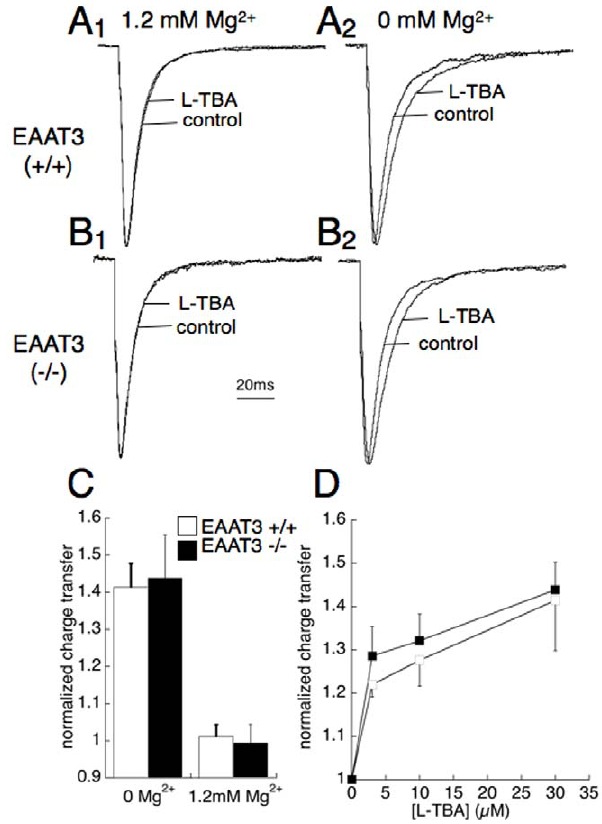
Figure 4. Actions of L-TBA (30 m M) on postsynaptic responses at the CA1 Schaffer collateral-pyramidal neuron synapse of EAAT3 + / + (A) and EAAT3 2 / 2 (B) mice. Representative whole cell recordings ( 2 60 mV) showing effect of L-TBA on EPSCs evoked by stimulation in stratum radiatum in the presence (A 1 , B 1 ) and absence (A 2 , B 2 ) of physiological extracellular Mg 2 + (1.2 mM). (C) Summary of data showing EPSC charge transfer increase in slices from EAAT3 ( + / + ) and ( 2 / 2 ) mice by 30 m M L-TBA in the absence and presence of Mg 2 + (n=5–7 slices; p , 0.05). Data normalized to the charge transfer in slices from EAAT3 ( + / + ) mice. (D) Summary data showing no significant difference in L-TBA concentration-dependence of EPSC charge transfer increase (normalized to control) for EAAT3 + / + (open squares) and EAAT3 2 / 2 (filled squares)